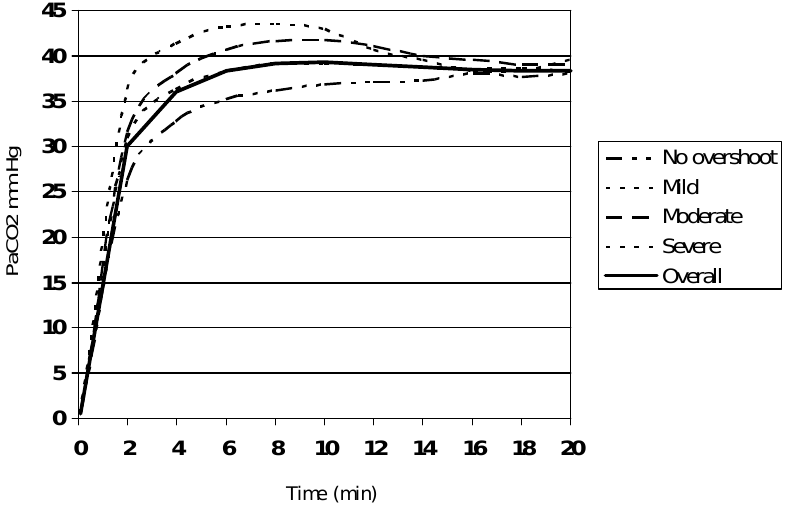
Figure 1. The TcPCO values tend to converge after minute 10. At minutes 12 and 14, the 2 overshoot phenomenon seems to